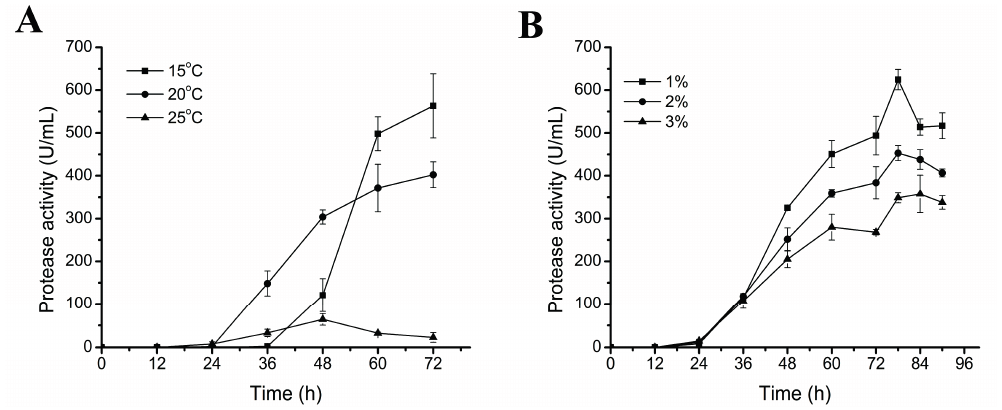
Figure 1. Effects of culture temperature ( A ) and inoculation amount ( B ) on the protease production of D25 in the basal medium. The graph shows data from triplicate treatments (mean ±